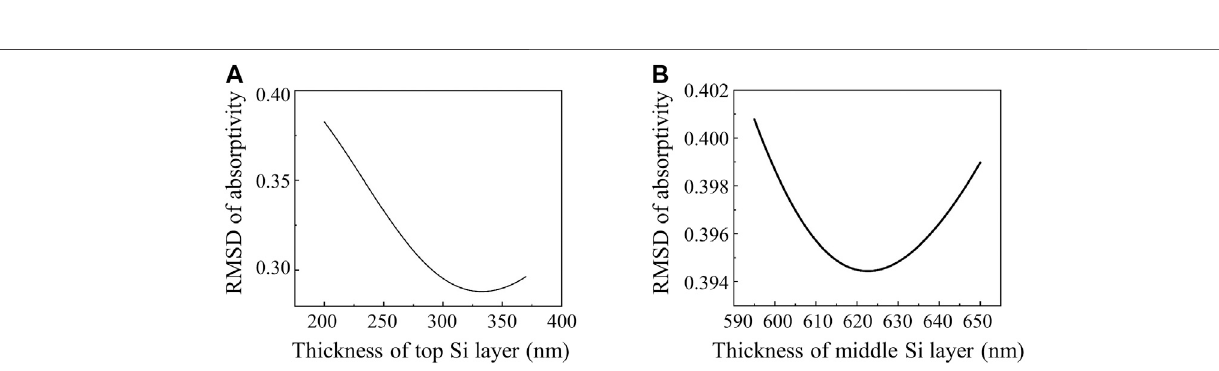
where S11 and S21 are the S-parameters of the wavelength- selective absorber. The results showed that the similarity of the